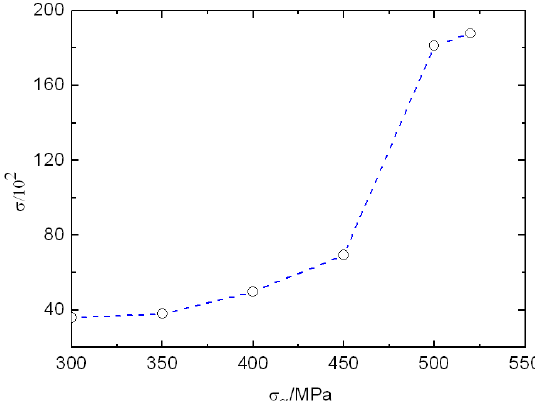
Figure 4: Standard deviation of stress at different stress